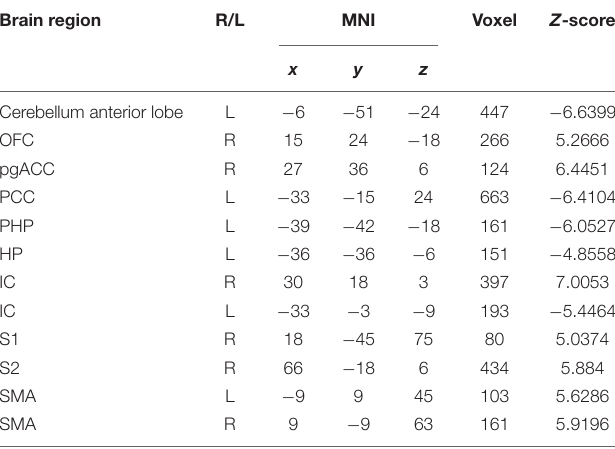
TABLE 5 | Summary of the brain regions indicating functional connectivity with the rACC in nocebo response in male participants ( p < 0.05, FDR < 0.05). Brain region R/L MNI